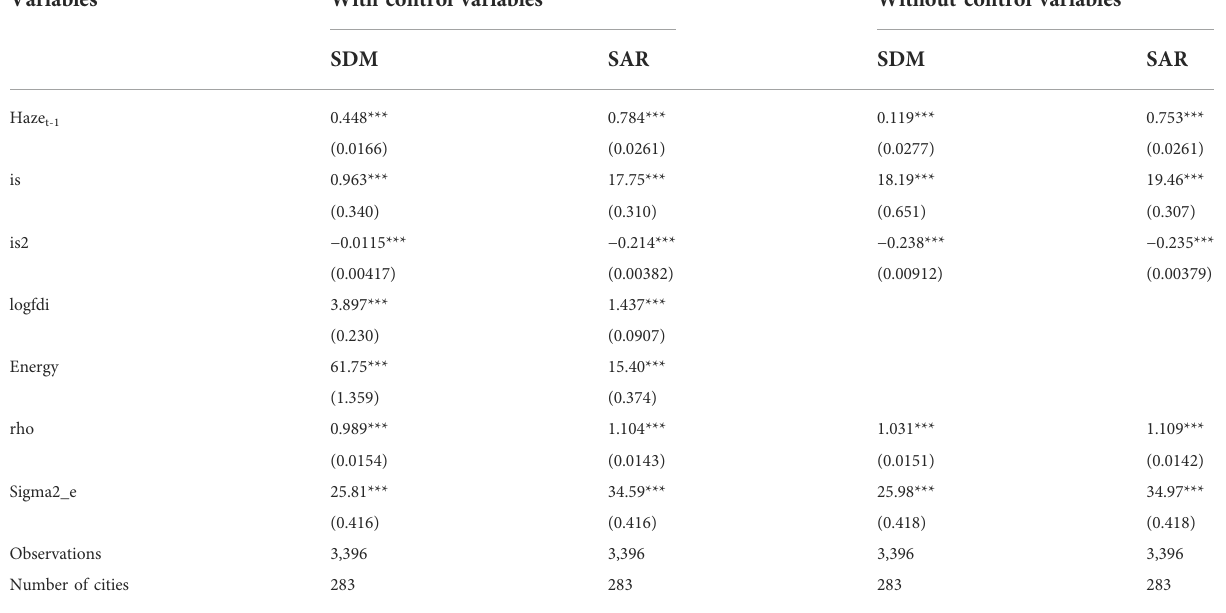
TABLE 2 The in fl uence coef fi cient of industrial structure on haze pollution. Variables With control